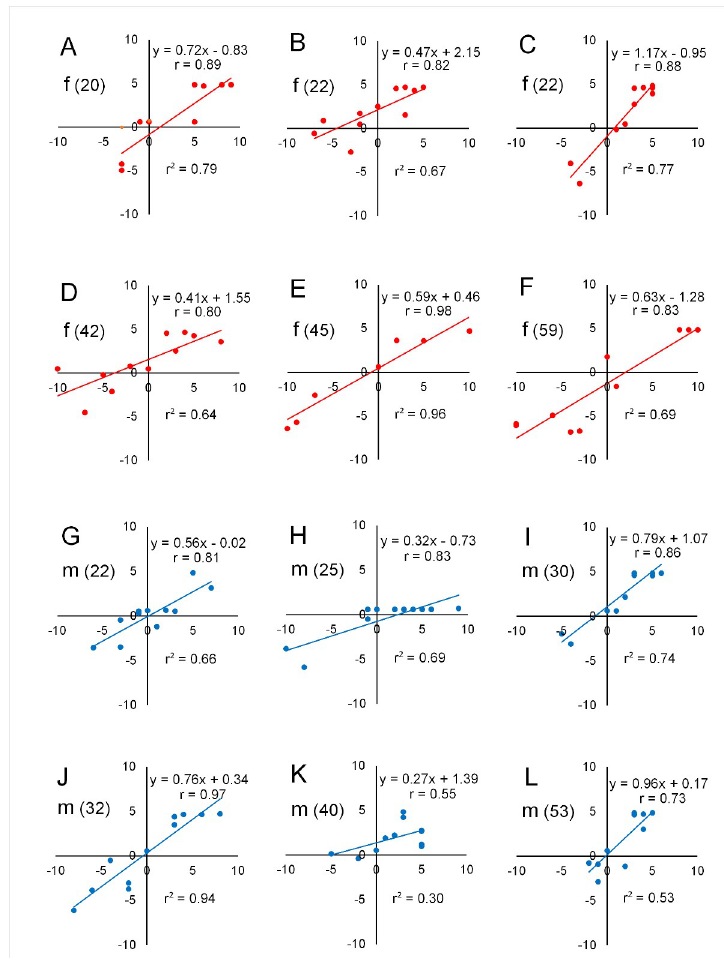
Fig 5. Scatterplots between predicted and perceived hedonic ratings in response to 11 stimuli in 12 participants (single case analysis). Six females (f), depicted in red, are shown in A to F, and six males (m), depicted in blue, are shown in G to L, from younger to older, with ages shown in parentheses. The calculated hedonic ratings are shown in the ordinates and the perceived hedonic ratings in the abscissas. The regression formula, Spearman’s correlation coefficient (r), and coefficient of determination (r 2 ) are shown in each graph. P < 0.001 for A, C, E, I and J; P < 0.01 for B, D, F, G, H and L; and P > 0.05 for